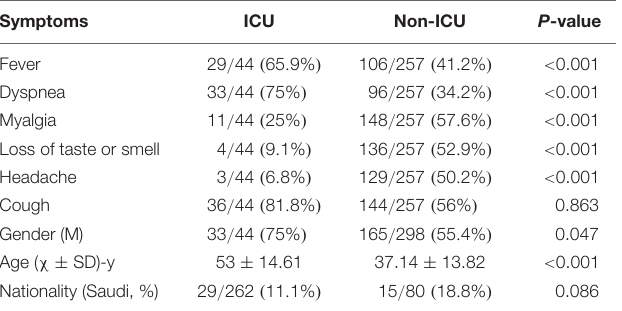
TABLE 2 | Demographics and clinical characteristics of COVID-19 patients stratified by ICU status.